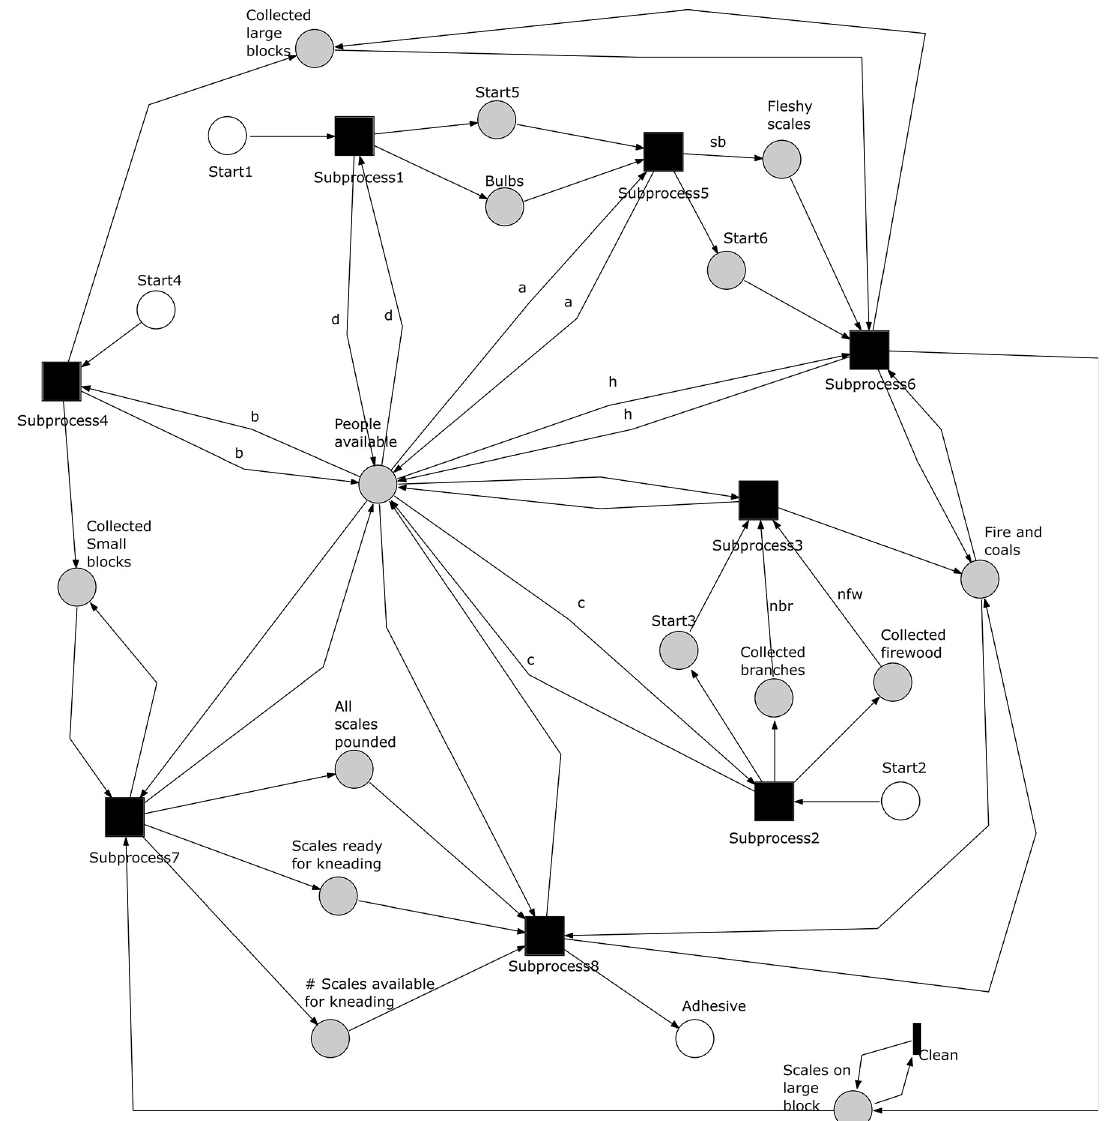
Fig 11. Petri net showing the subprocesses of A . coranica model. Subprocesses represented as macro-transitions (black squares) and the places connecting subprocesses highlighted in